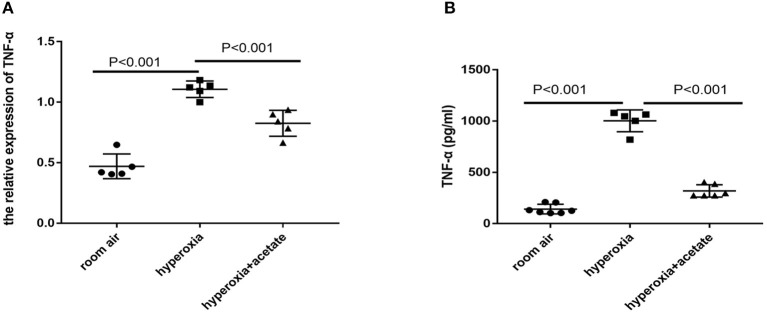
Acetate decreases pro-inflammatory factors in the mouse lung. The pulmonary mRNA levels of TNF-α (A). The pulmonary protein levels of TNF-α (B). n = 5–7/group from 3 independent experiments; data are presented as the means ± SD.